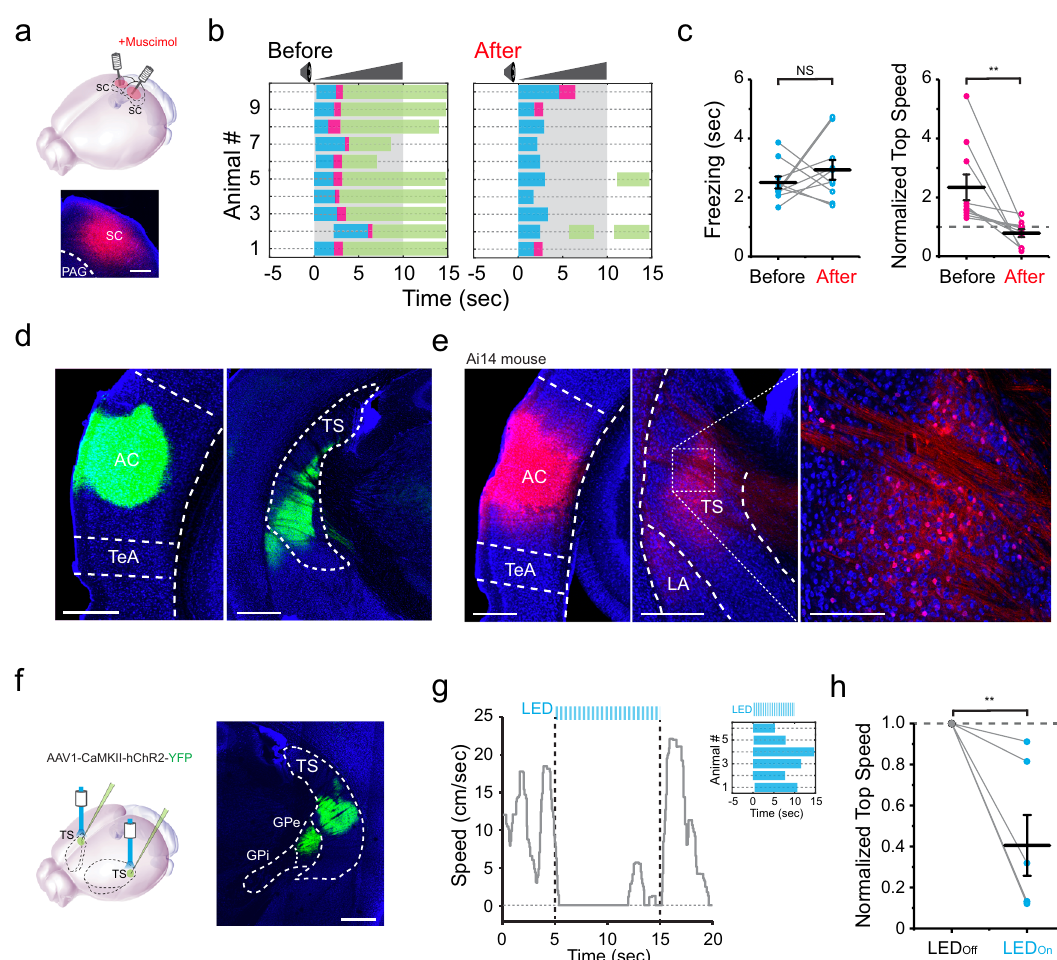
Fig. 3 Differential roles of the superior colliculus (SC) and the tail of the striatum (TS) in the crescendo-induced defensive behavior. a Silencing SC with muscimol. Scale bar, 200 µ m. PAG, periaqueductal gray. b Crescendo-induced behavioral responses of 10 mice two days before (left) and right after (right) silencing SC. c Comparison of crescendo-induced freezing duration (left, p = 0.358, two-sided paired t test, t = − 0.968, n = 10 mice) and normalized top speed (right, ** p = 0.005, two-sided paired t test, t = 3.239, n = 10) before and after silencing SC. Data are presented as mean ± s.e.m. The center presents the mean value and the bar represents s.e.m. d Injection of AAV-GFP in AC. Left, expression at the injection site. Right, AC axons in TS. Scale bars, 500 µ m. Blue, Nissl staining. AC auditory cortex; TeA temporal association cortex. e Injection of AAV1-hSyn-Cre in AC of Ai14 (Cre-dependent tdTomato) mice. Left, tdTomato (red) expression at the injection site. Middle and right (zoom in), transsynaptically labeled AC-recipient neurons in TS. Blue, Nissl staining. Scale bars, 500 (left and middle) and 100 (right) µ m. LA, lateral amygdala. f Left, injection of AAV-CaMKII-ChR2 in TS. Right, ChR2 (green) expression in TS. Scale bar, 500 µ m. GPe globus pallidus externa, GPi globus pallidus interna. g Plot of speed for an example animal in response to LED activation (10 s) of TS neurons. Inset, behavioral outcome for six mice. h Top speed (normalized to the top speed during 5-s window before stimulation trigger) in the LED off and LED on condition. ** p = 0.005, two-sided paired t test, t = 4.002. Data are presented as mean ± s.e.m. The center presents the mean value and the bar represents